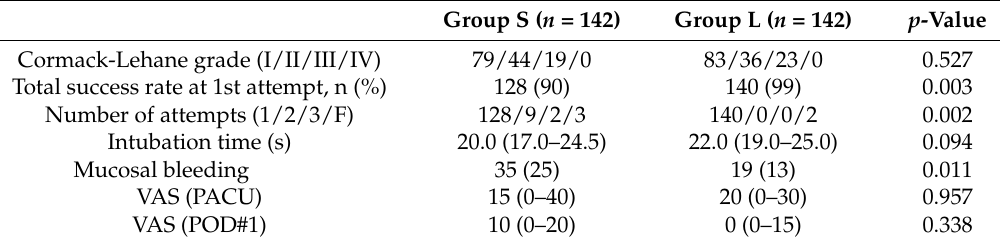
Table 2. Intubation parameters and perioperative